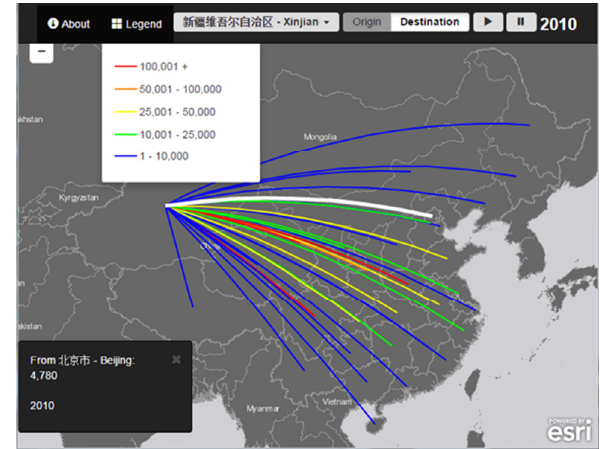
Figure 6b Migration into Xinjiang in 2010